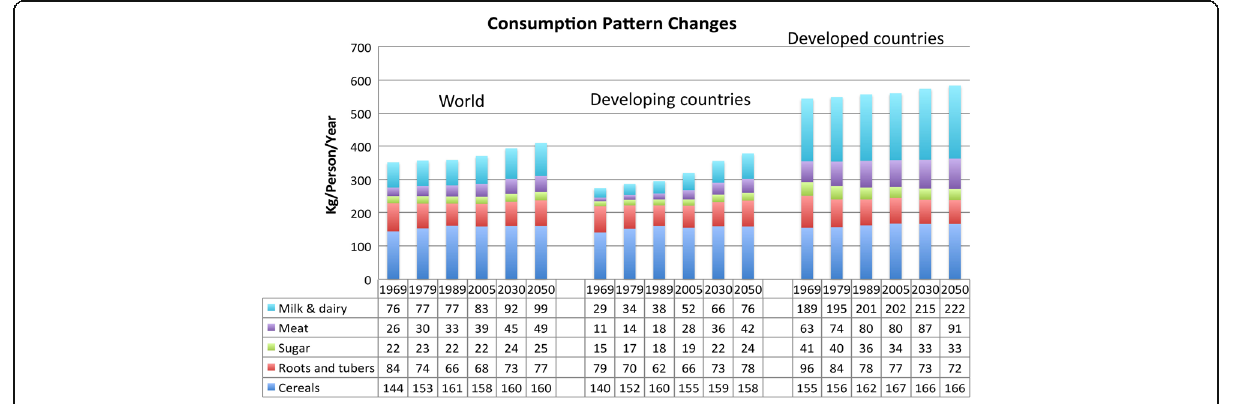
Fig. 1 Increasing consumption of meat and milk in developed and developing countries based on the statistics of FAO